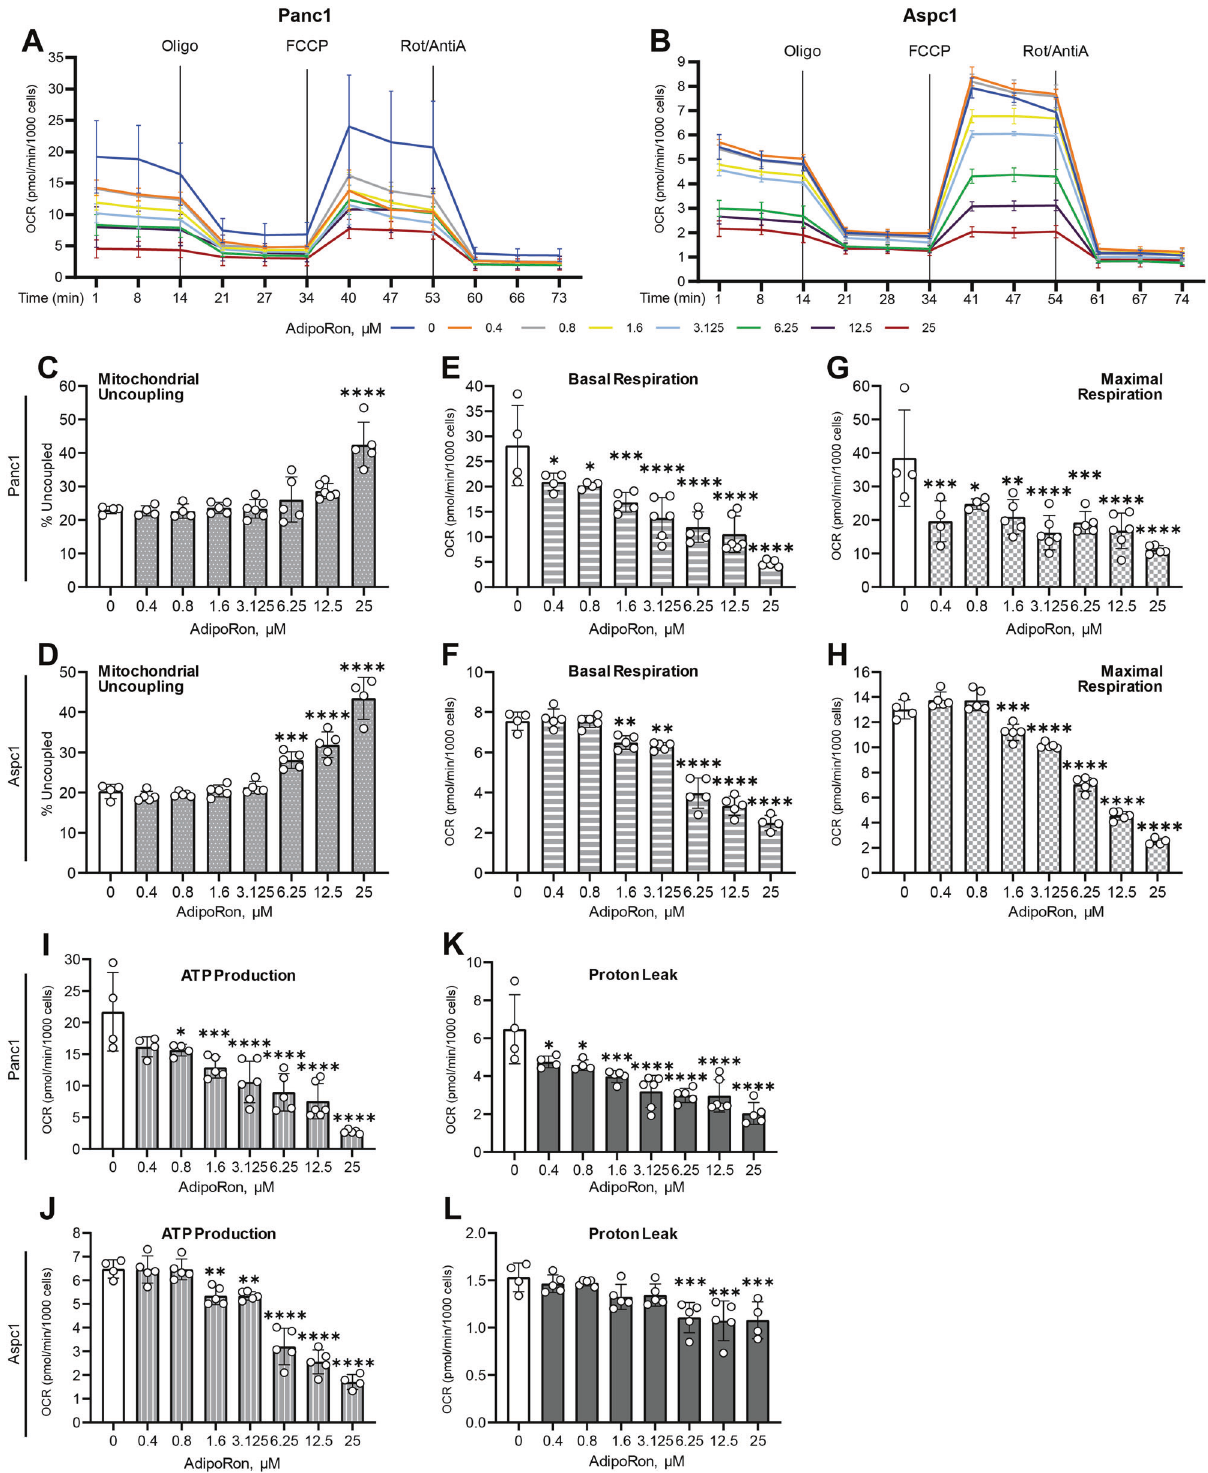
Fig. 1 AdipoRon suppresses metabolic parameters in a dose-dependent manner. Seahorse XFe96 bioanalyzer was used to measure oxygen-consumption rate (OCR) in Panc1 ( A ) and Aspc1 cell lines ( B ) either untreated (0) or pretreated with 0.4, 0.8, 1.6, 3.125, 6.25, 12.5, or 25 μ M AdipoRon for 45 min, with initial basal measurements followed by sequential injections of oligomycin, carbonyl cyanide-4- (tri fl uoromethoxy)phenylhydrazone (FCCP), and rotenone/antimycin A. Mitochondrial uncoupling ( C , D ), basal respiration ( E , F ), maximal respiration, ( G , H ), ATP production ( I , J ), and proton leak ( K , L ) were calculated from the OCR measurements in ( A , B respectively). One-way ANOVA, n ≥ 3; error bars, SD; * P < 0.05.